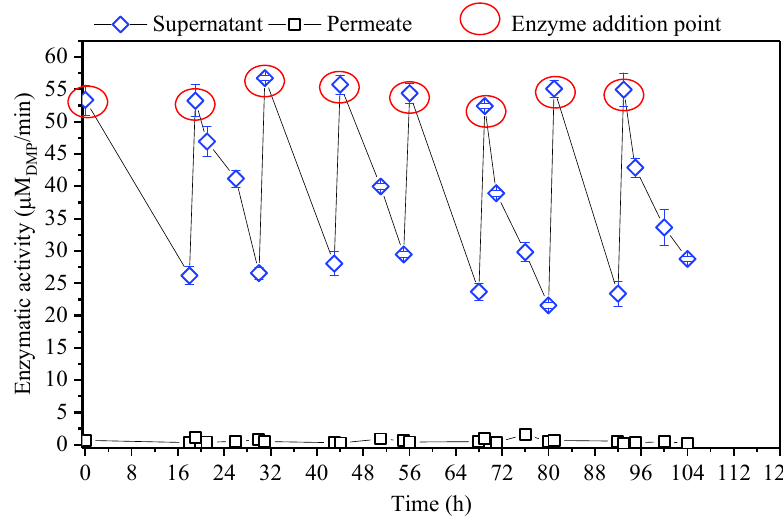
Figure 5. Enzymatic activity in the enzymatic membrane reactor (EMR) supernatant and permeate during the 112 h operation. The data were the average and standard deviation of three measurements.